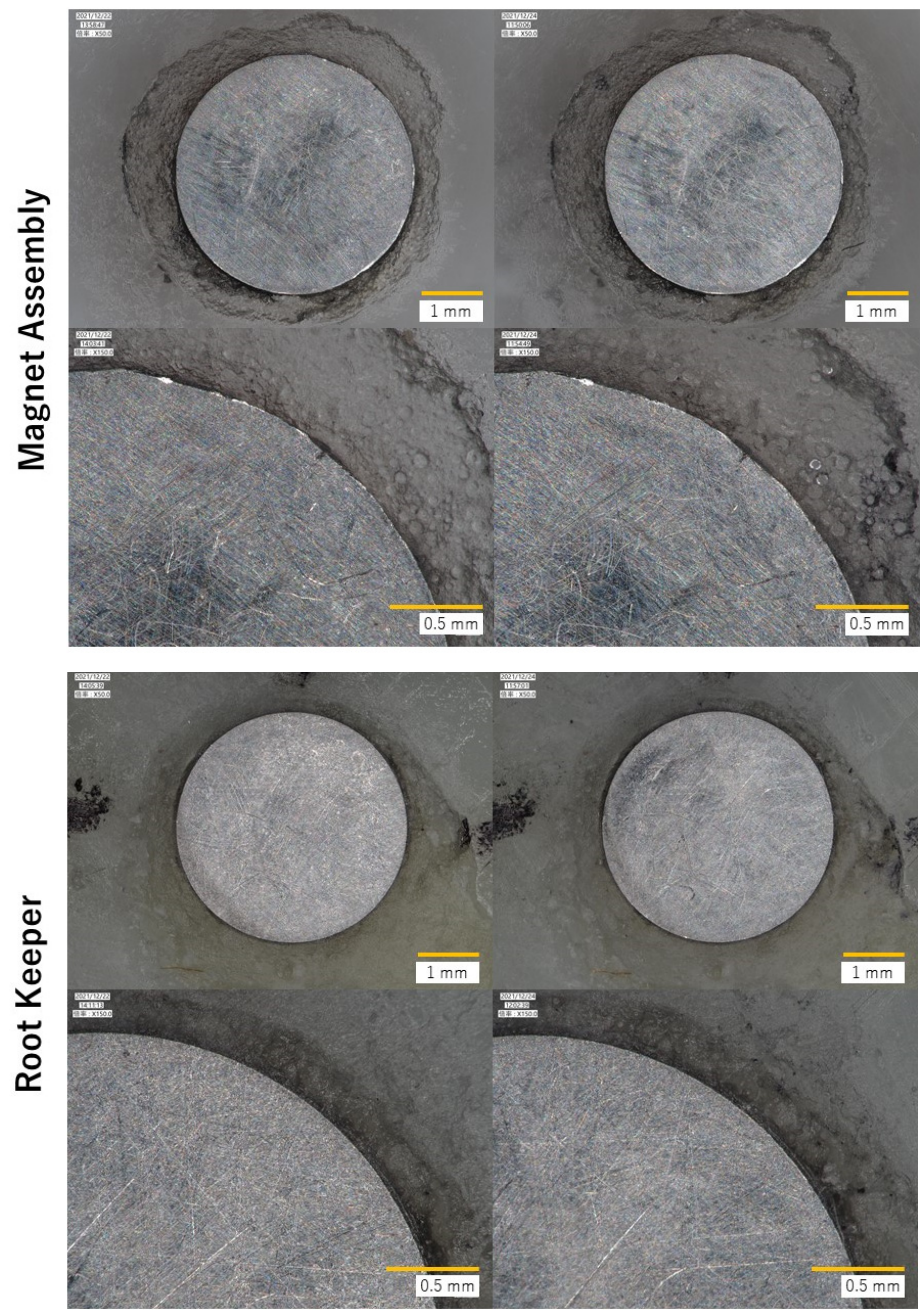
Figure 6. Surface evaluation of MA and RK between before ( left ) and after ( right ) load test. Upper: 50×, lower: 150× magnification.